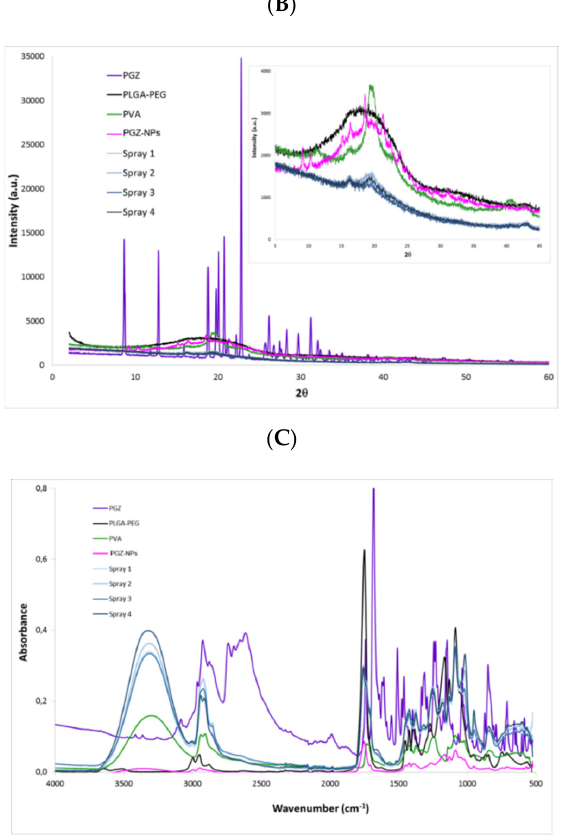
Figure 4. Interaction studies for PGZ-NPs. ( A ) Differential Scanning Calorimetry, ( B ) X-ray diffraction patterns, ( C ) FTIR spectra.